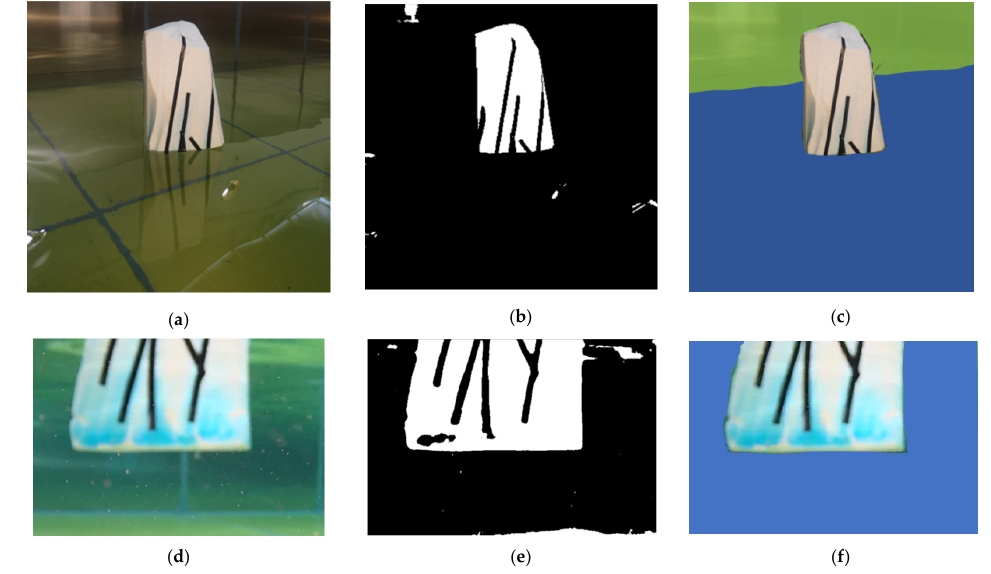
Figure 18. Obstacle image segmentation results. ( a ) Overwater image of obstacle. ( b ) Region growing segmentation result. ( c ) Automatic multi-seed segmentation result. ( d ) Underwater image of obstacle. ( e ) Region growing segmentation result. ( f ) Automatic multi-seed segmentation result.